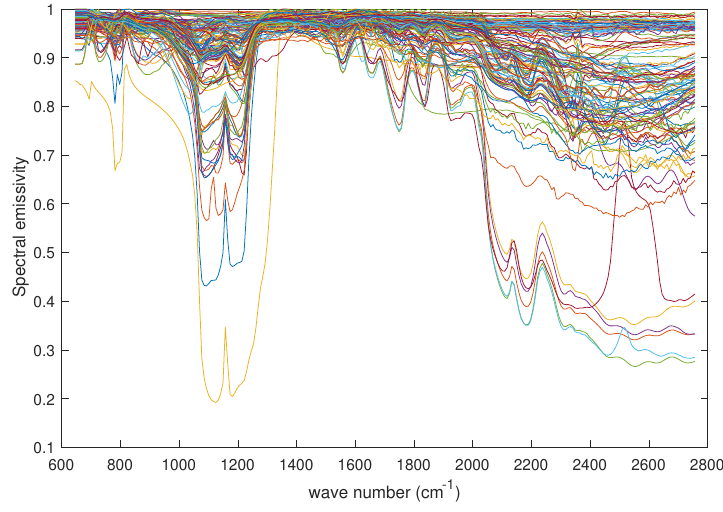
Figure 6. Ensemble of laboratory emissivity spectra used to construct the PCA basis.